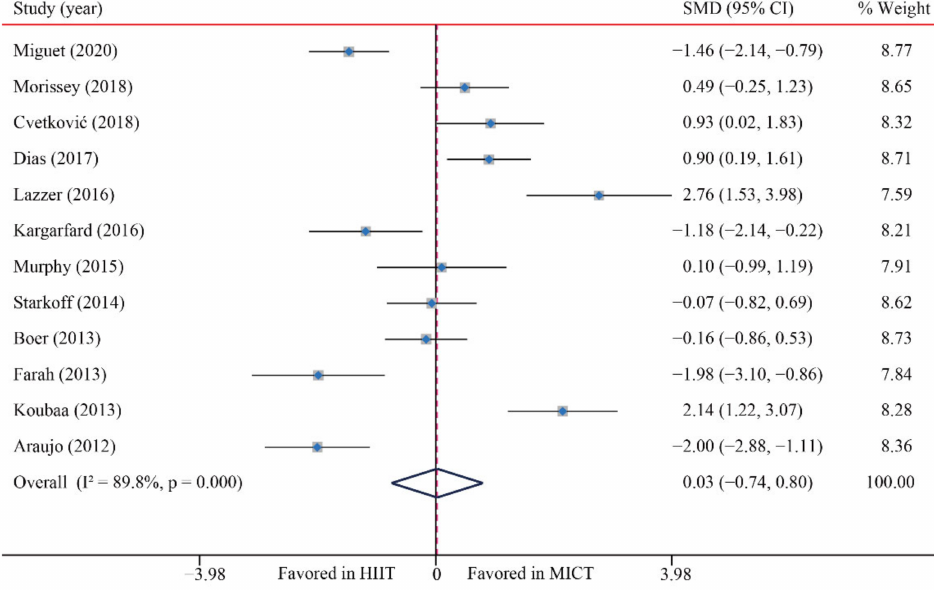
Figure 3. Effect of HIIT versus MICT on body mass